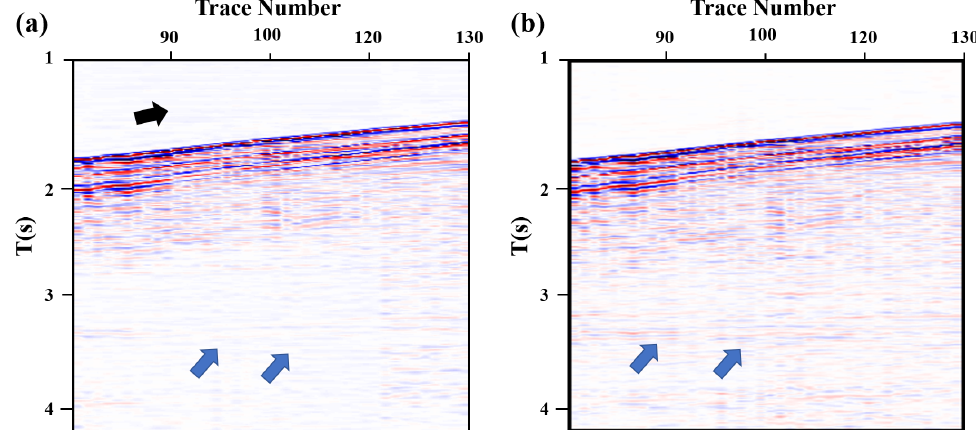
Figure 14. The enlarged rectangular area of ( a ) the UNet and ( b ) the ACB-UNet denoising results.